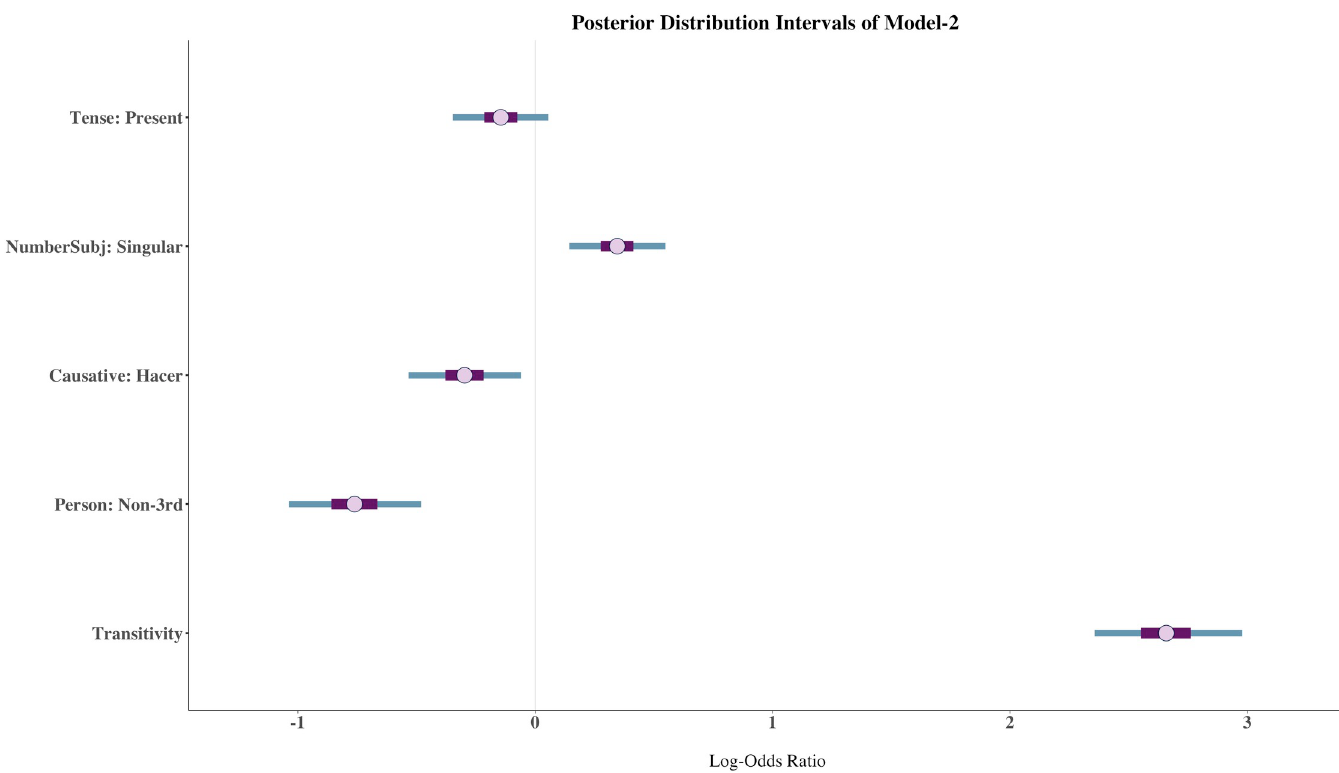
Fig 3. Posterior distribution intervals of Model-2. The dot represents the posterior mean estimate. The thicker purple lines show 50% and the thinner blue lines 90% credible intervals, respectively.